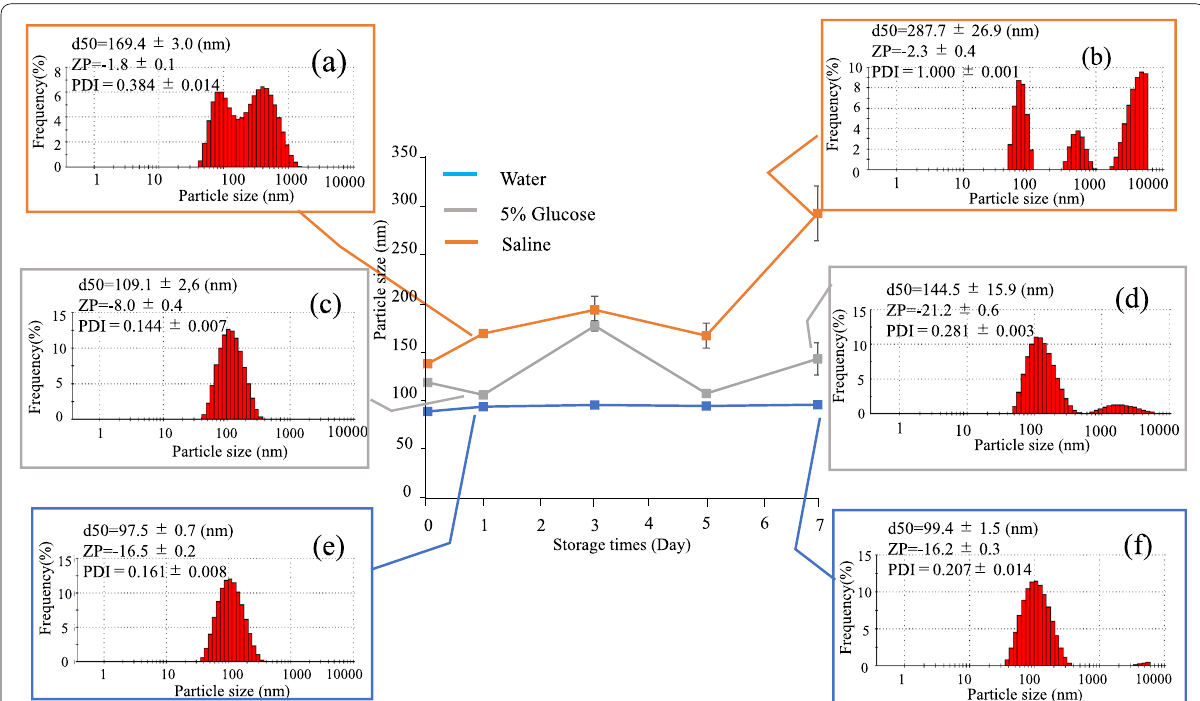
Fig. 3 Changes in particle size and zeta potential of nanoparticles of Sol/ASC-DP/NOB 7 in distilled water (DW), 5% glucose solution, and saline. Each point represents the